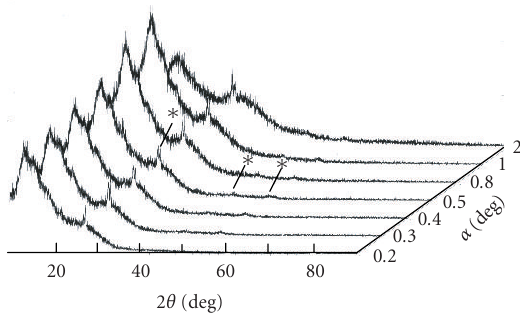
Figure 4: Grazing incidence X-ray di ff raction (GIXRD) at di ff erent incidence angles. CdS as deposited ( ∗